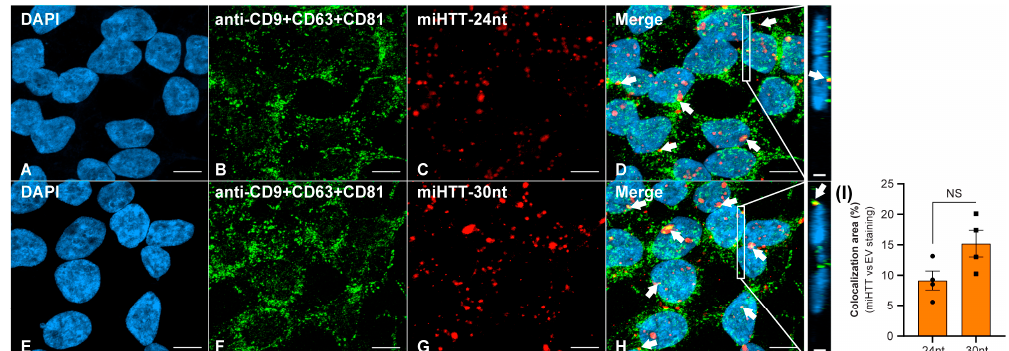
Figure 4. Fluorescent in situ hybridization (FISH) and immunocytochemical (ICC) staining in the HEK293-miHTT cell line for visualization and colocalization analysis between miHTT and EV-marker signals. ( A – H ) Visualization of EV-marker signals (green) using a cocktail of antibodies (anti-CD9 + CD63 + CD81). Detection of miHTT (red), using miHTT-24nt or miHTT-30nt probes. White arrows indicate areas of colocalization (yellow) between EV-marker signals and miHTT miRNAs. ( I ) Quantification of EVs and miHTT colocalization area ( µ m 2 ). ( D , H ) Inserts show orthogonal projections (xz view). For each single focal plane, the total area ( µ m 2 ) of red (miHTT), green (EVs), and yellow (overlap red: green) pixels were quantified. The total area ( µ m 2 ) of double-positive pixels was normalized to the total area of red pixels. Scale bars main panels A–H = 10 µ m. Scale bars insert panels within D & H = 2 µ m. nt, nucleotide; NS, non-significant.